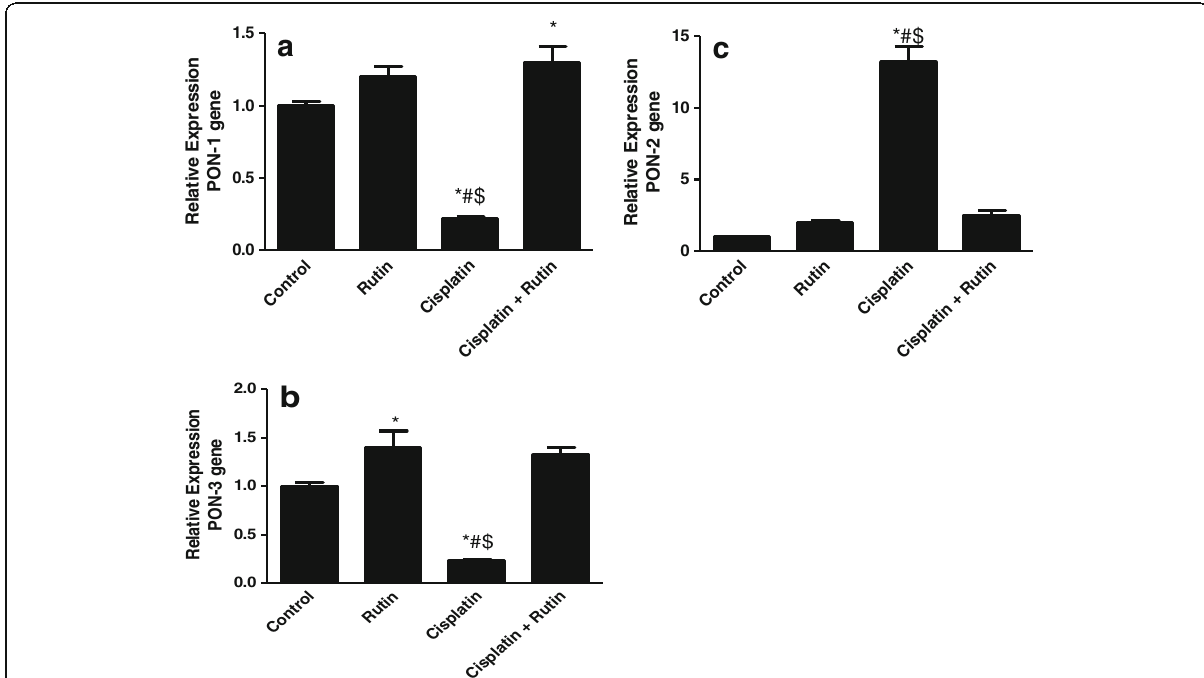
Fig. 3 The Effect of Cisplatin, rutin, and their combination on the expression levels of PON-1 ( a ), PON-2 ( b ) and PON-3 ( c ) in rat brain tissues. Data were presented as mean ± SEM ( n = 10). *, # and $ indicate significant change from control, rutin and CP + rutin, respectively, at P < 0.05 using ANOVA followed by Tukey – Kramer as a post ANOVA